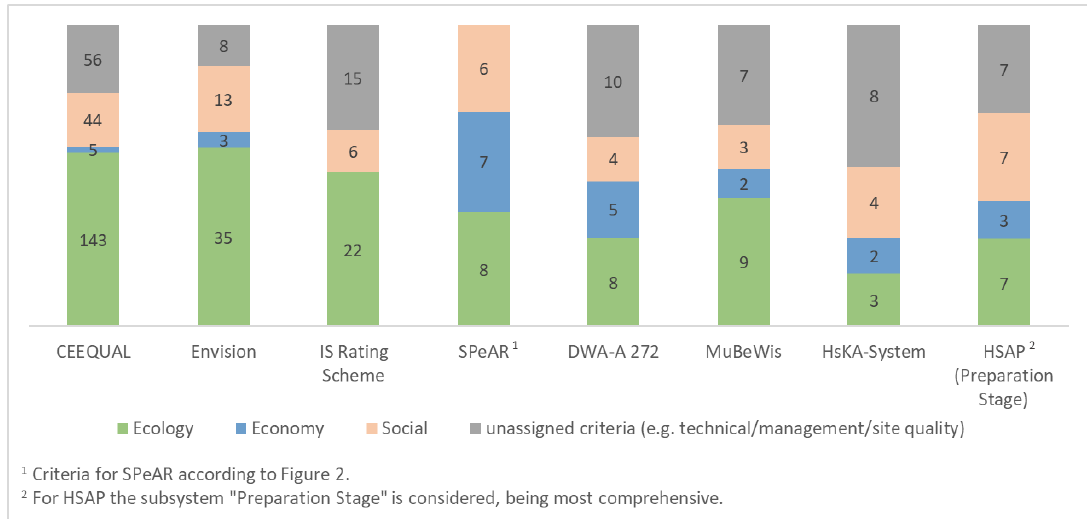
Figure 3. Number of criteria covering the three sustainability dimensions in different schemes.